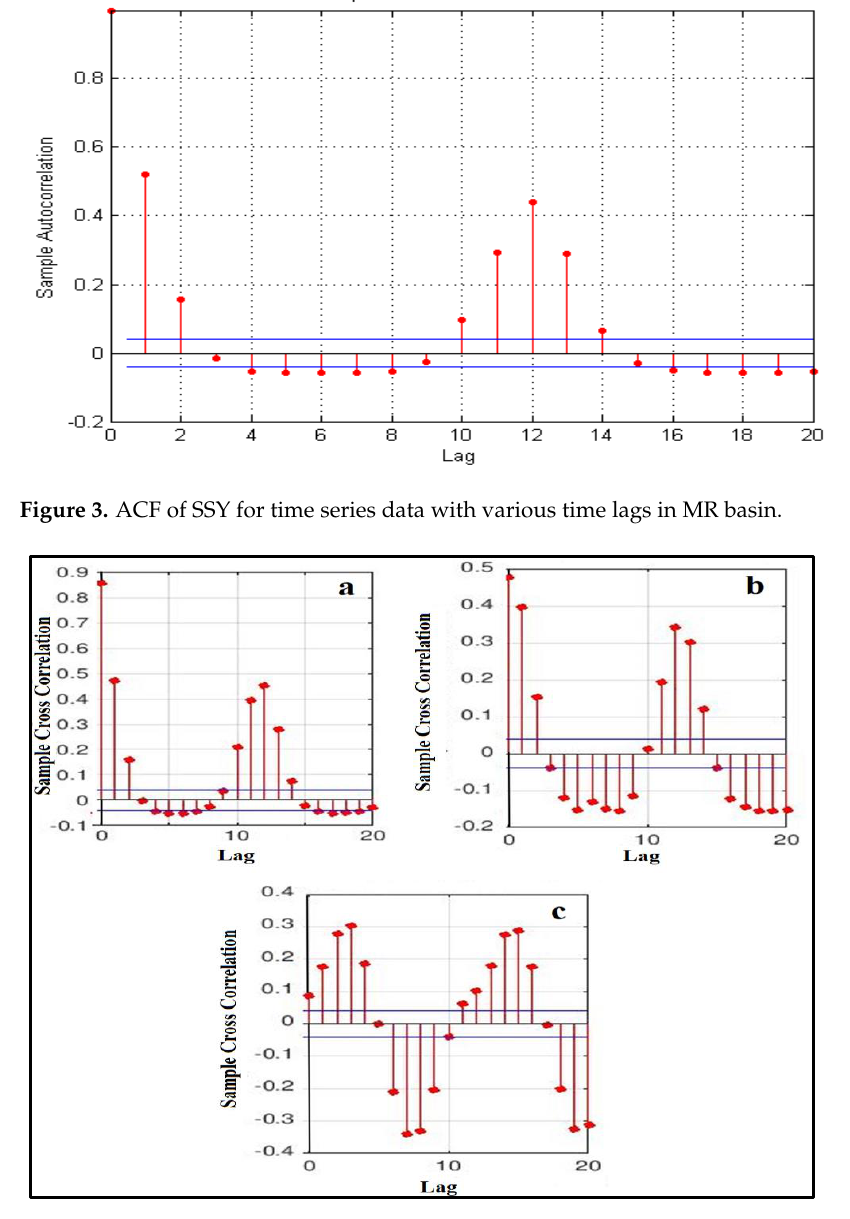
Figure 4. CCF plot of the hydro-climatical data between ( a ) Q and SSY ( b ) RF and SSY ( c ) T and